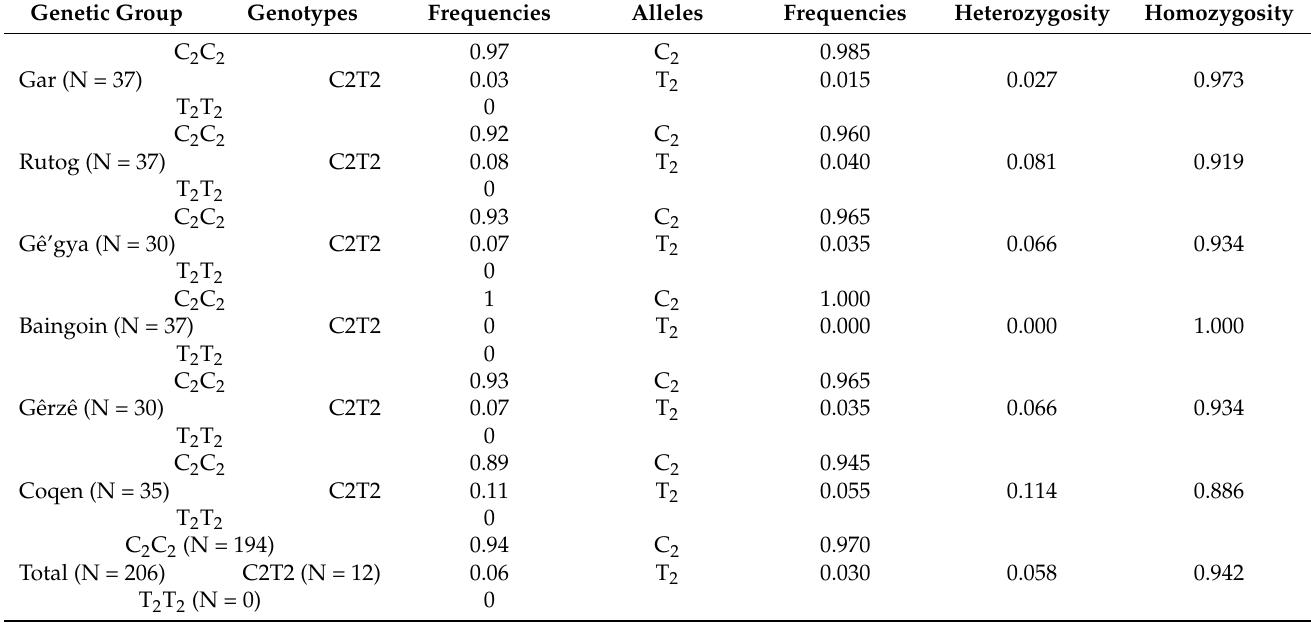
Table 4. Genotype and allele frequencies of gene KAP 1.4 of the cashmere goat at the 209 bp locus. “N” represents the total number of cashmere goats in the counties.